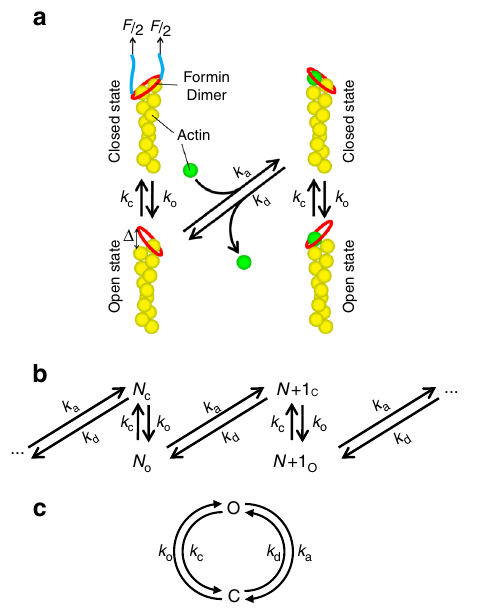
Fig. 5 Kinetic model of FH2 dependent actin polymerization. a Schematics of the closed-open transition of FH2 associated at the barbed end and recruitment of actin monomers at the open state of the FH2 ring. b The corresponding transition diagram of actin elongation. c The corresponding transition diagram of recruiting one actin monomer, from which the polymerization speed can be